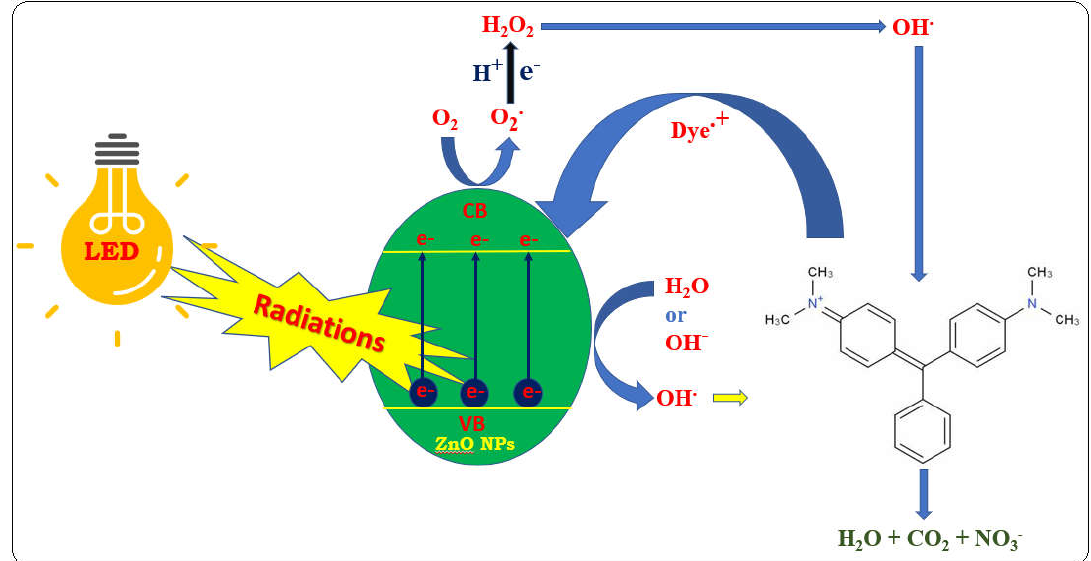
Figure 1. Physical mechanism of degradation of dye by NPs. Various reaction parameters, such as the effect of change in Fenton’s reagent concen- tration, CO 2, and COD measurements, and the effect of the bubbling of N 2 and O 2 purging, were evaluated during MG dye degradation. All the observed results are correlated and the improved catalytic efficiency is interpreted based on the structural and morphological findings of the prepared nanosized ZnO.